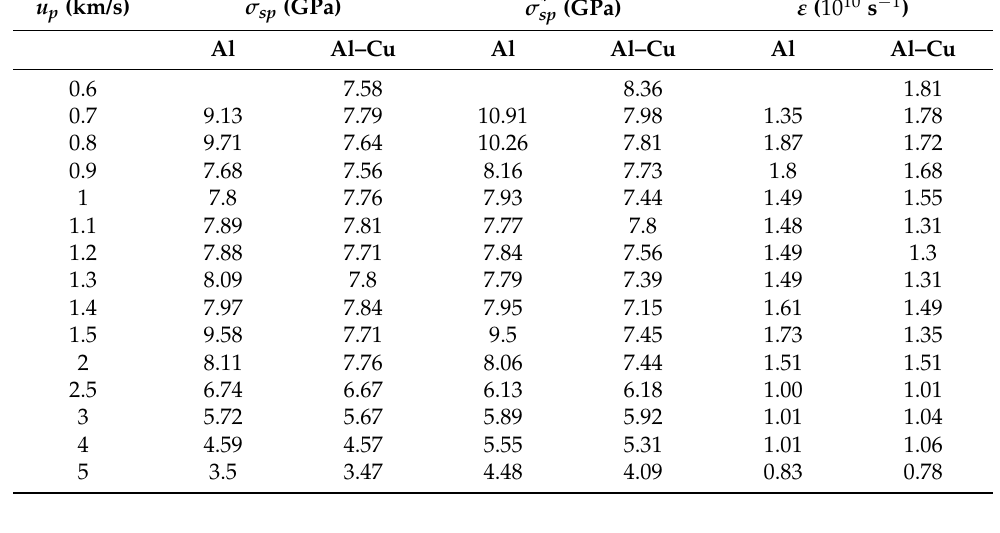
Table 1. Spall strengths given by the maximum tensile stress ( σ sp ) and Equation (1) ( σ ∗ sp ). Strain rate given by Equation (2).